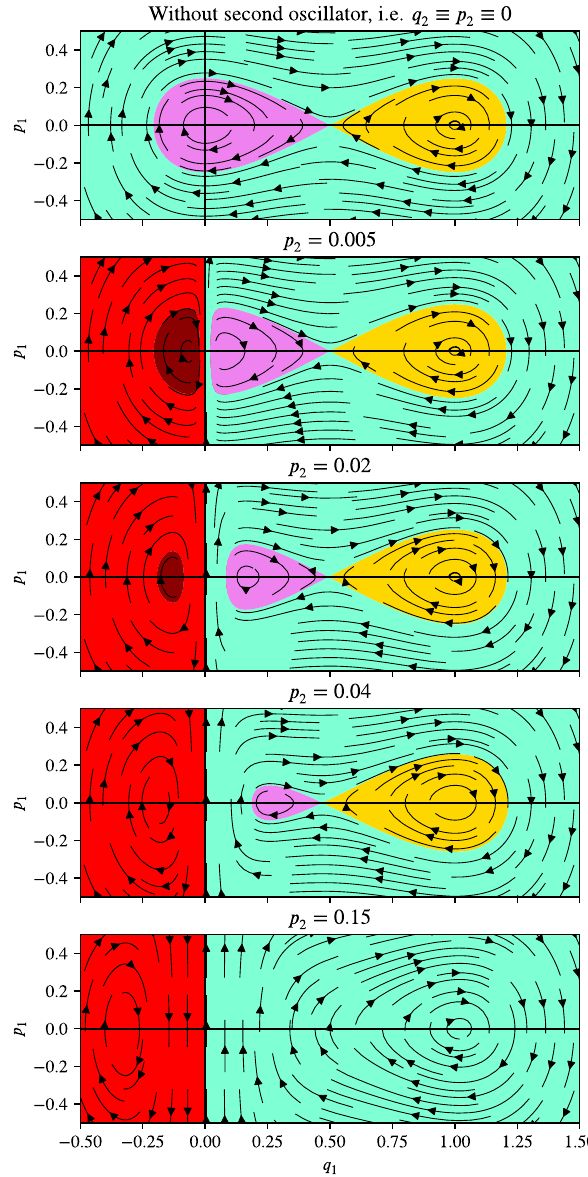
Fig. 1 Strong coupling splits the naïve vacuum. Static vacua q 1 = 0 and q 1 = 1, with q 2 = 0, satisfy the field equations from Eq. (4). Without the second oscillator, the phase portrait would be as in the top frame. Vacuum fluctuations in both the violet and gold regions are per- turbatively captured. However in reality, the second oscillator drives a second, inherently non-perturbative separatrix through the naïve vac- uum at q 1 = 0